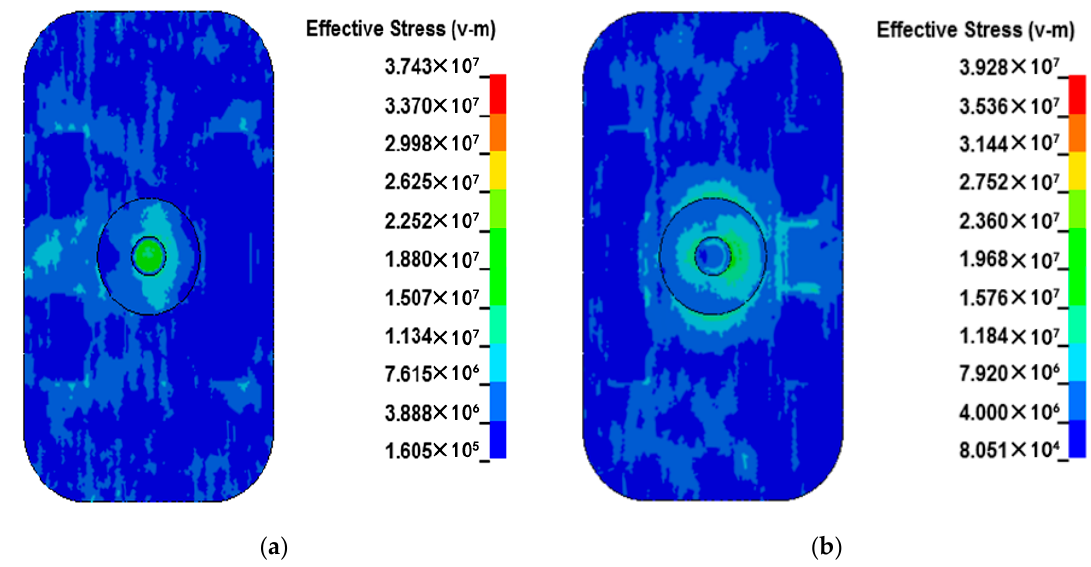
Figure 19. Distribution of plate stress under 100 Hz. ( a ) plate stress distribution at the maximum of upper half cycle. ( b ) plate stress distribution at the maximum of lower half cycle.